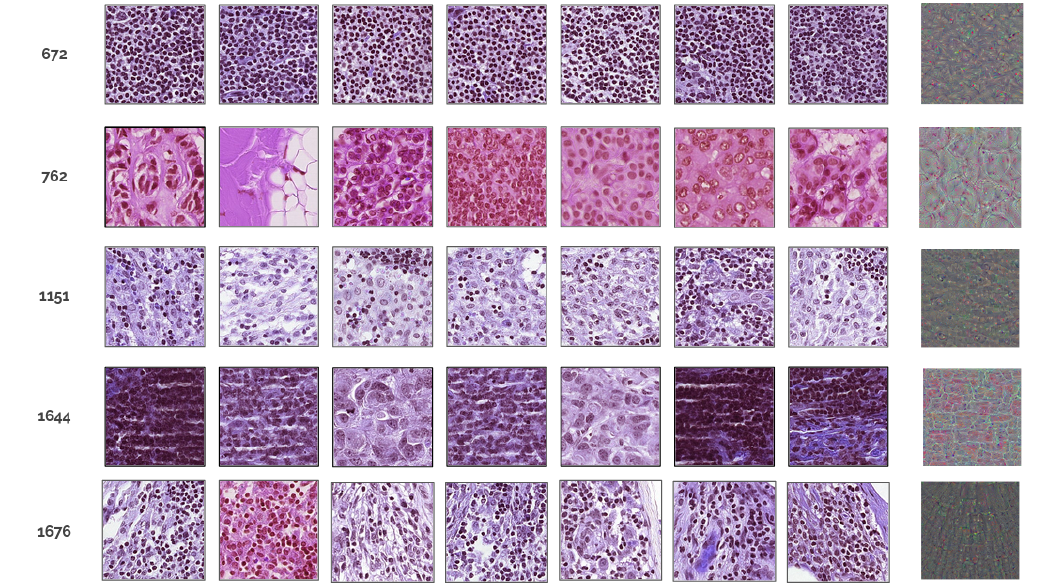
Figure A3. Features selected by Attention-based model to describe “normal” class.